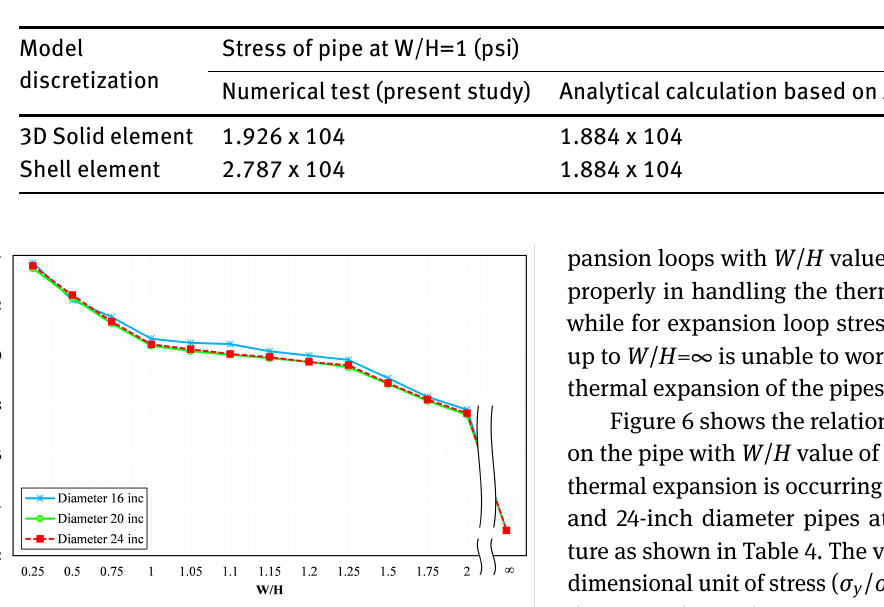
Table 5: Validation test between numerical test and analytical calculation.